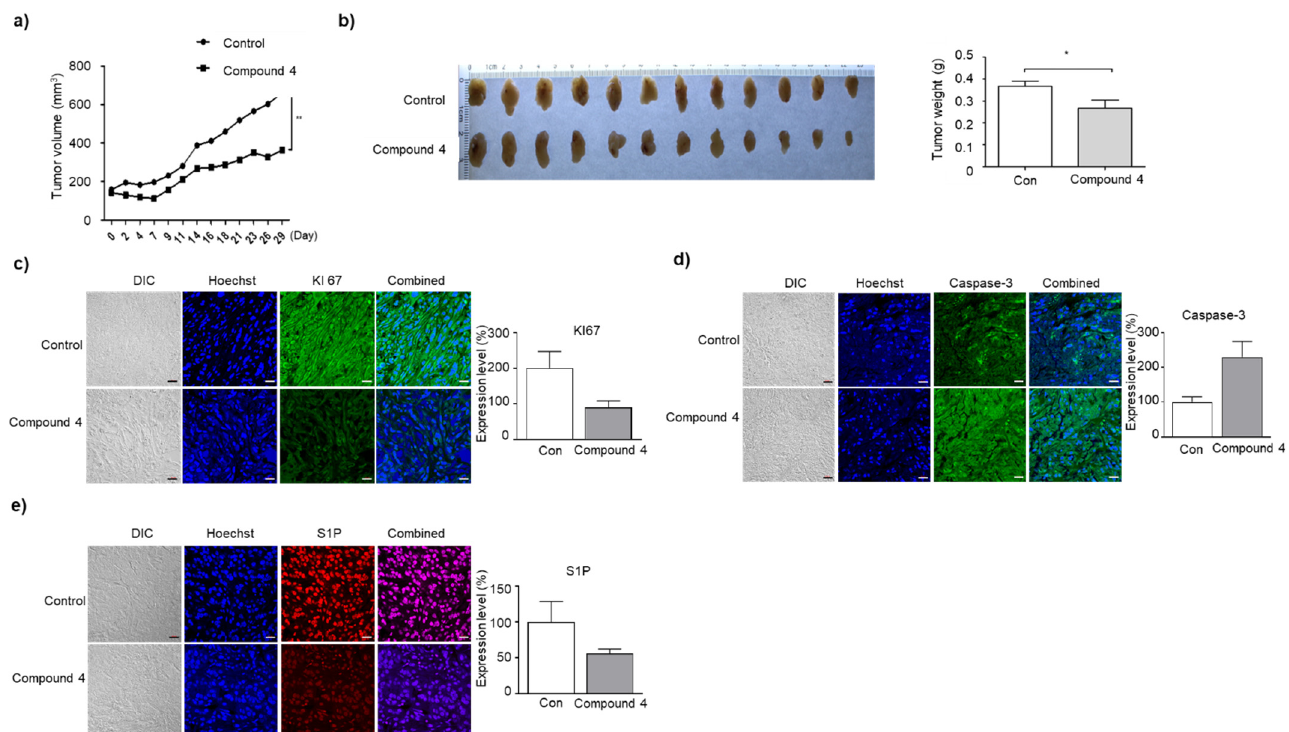
Figure 6. Compound 4 inhibits the growth of A549 cell-induced tumor xenograft in nude Balb/c mice; ( a ) The effectiveness of inhibiting tumor growth was observed in A549 tumor-bearing nude Balb/c mice after intraperitoneal administration of vehicle or Compound 4 (5 mg/kg) 3 times a week for a period of 29 days; ( b ) Photographs were taken and weights were measured for isolated tumors from each group on day 29 after treatment; ( c – e ) Immunohistochemistry of tumor sections was per- formed for KI67, caspase-3 and S1P (scale bar 10 μ m, magnification 200 X ). Data are expressed as the mean ± S.D. * p < 0.05, and ** p < 0.01, compared with control group. Table 3. Change of blood chemistry in tumor xenograft mice for 29 days treated with vehicle and Compound 4 .